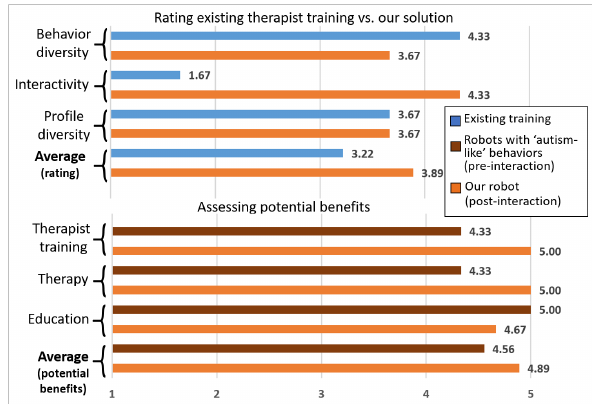
Figure 7: Summary of mean responses to questionnaire